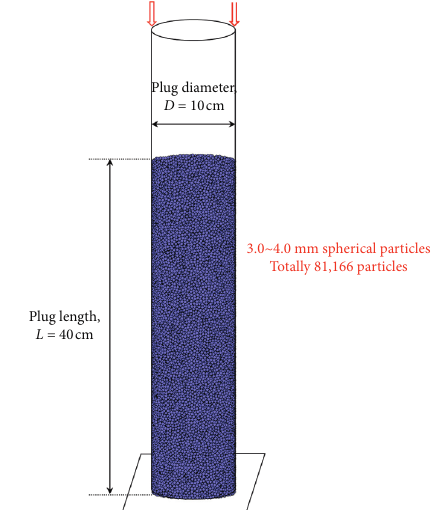
Figure 3: Illustration of the DEM model of soil